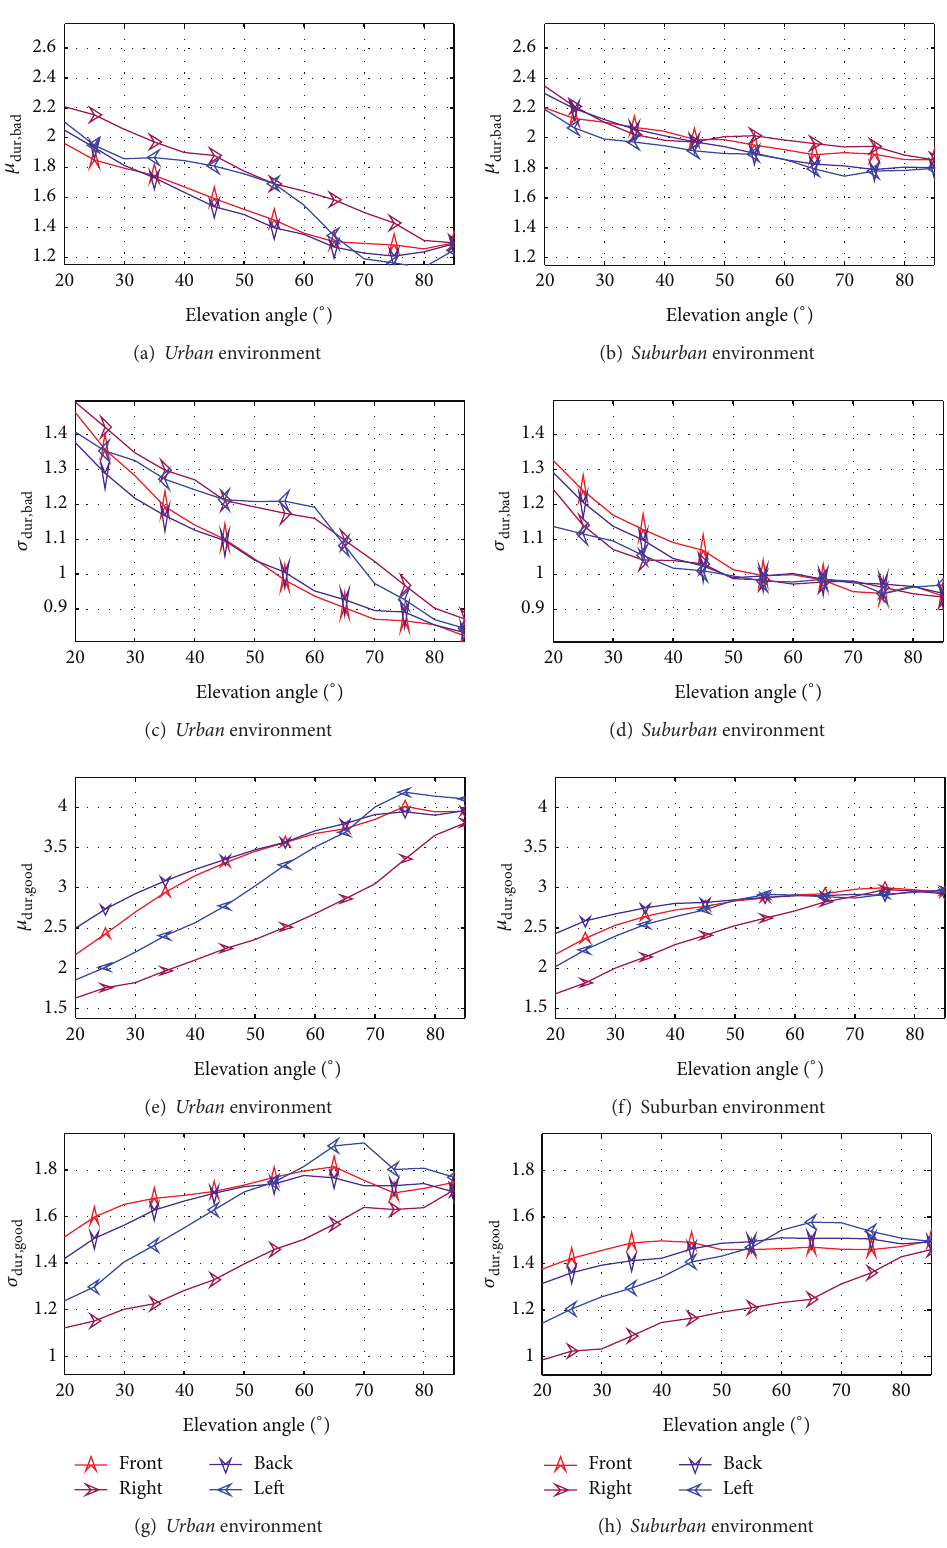
Figure 13: The log-normal mean ( 𝜇 respectively. The results refer to urban (left) and suburban (right) environment for different driving